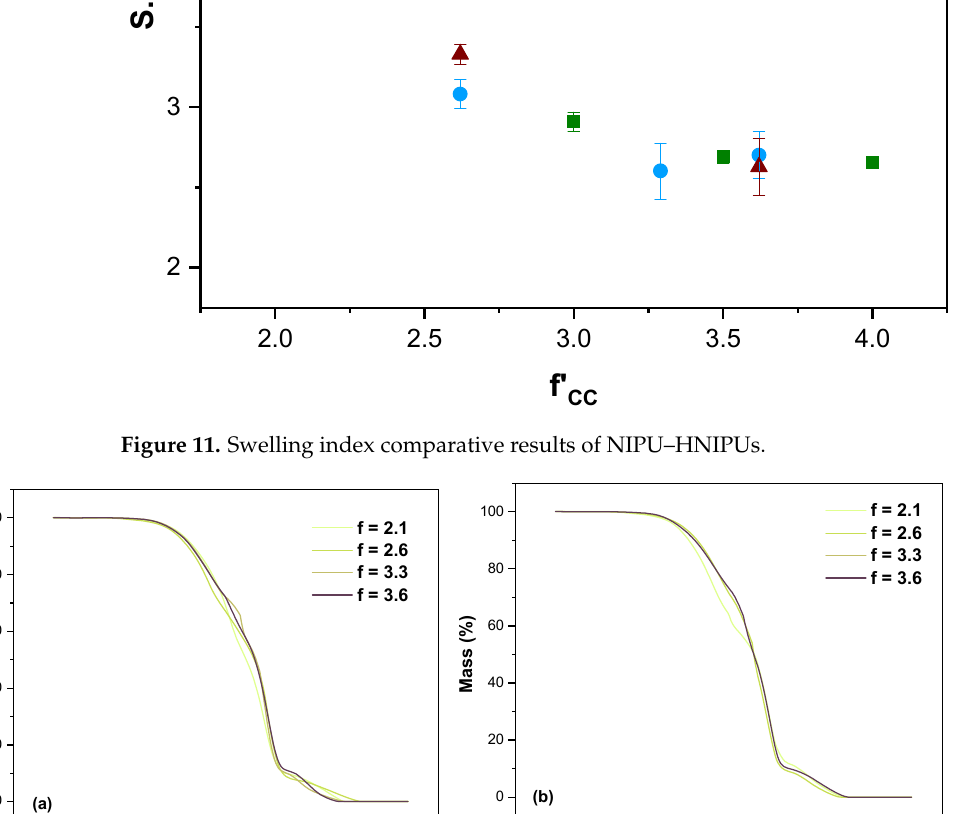
Figure 13. Glass transition temperature (T g ) comparative values for NIPU ‐ HNIPUs .